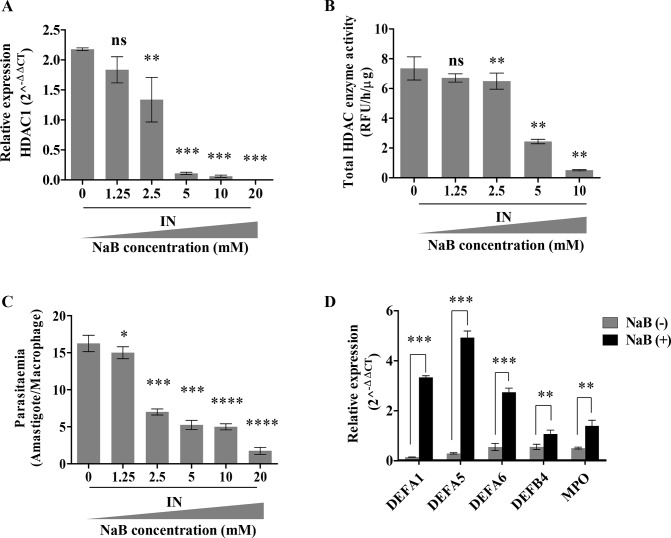
Effect of inhibition of HDACI activity by pharmacological inhibitor NaB on defense gene expression and parasite load in L. donovani infected THP-1 cells.THP-1 cells (105cells/ml) were incubated with L. donovani (20:1 MOI) for 3 h. Subsequently, the infected (IN) cells were incubated with increasing amounts of sodium butyrate (NaB) and were harvested at 6 h. A: Expression of HDAC1 was measured by qRT-PCR and transcription levels were plotted. The significance of the difference in expression levels was measured in infected (IN) and untreated samples (NaB concentration– 0 mM). B: Total HDAC activity in nuclear extracts of infected cells in the presence of increasing amounts of NaB was detected by fluorescent assay kit. The unit of fluorometric absorbance used is RFU (Relative Fluorescence Unit) and was calculated as mentioned in the methods section. The significance of the difference in activity was measured in infected (IN) and untreated samples (NaB concentration– 0 mM). C: Dose dependent impact of HDAC1 inhibitor on the parasitaemia count. Infected THP-1 cells (IN) were incubated in increasing concentrations of NaB. After 6 h, cells were stained and amastigotes enumerated visually. D: Expression levels of the host defense genes, post-infection in the presence and absence of NaB (5 mM) were quantified by qRT-PCR. Results represent the mean ± SD (n = 3). The statistical significance was determined using ANOVA, ns (P>0.05),* (P≤0.01 to 0.05), ** (P≤0.01), *** (P≤0.001), *** (P≤0.0001) and **** (P≤0.00001).